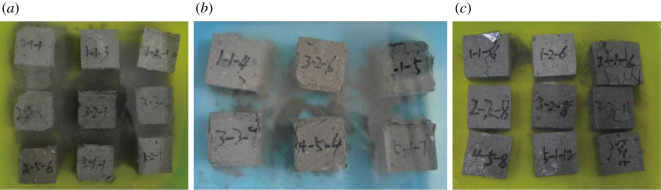
Failure modes of brick samples in the (a) Na2SO4, (b) MgSO4, and (c) Na2CO3 solutions.